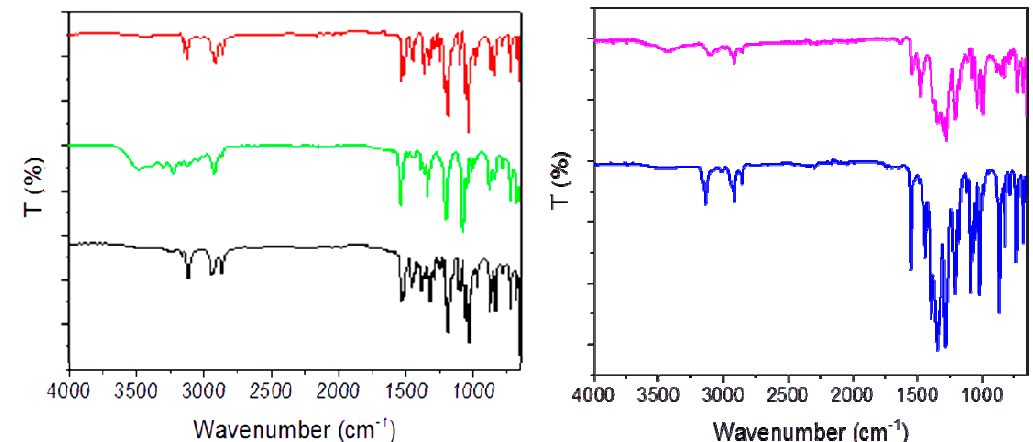
Figure 1. IR spectra of [Zn(tr 2 ad)Cl 2 ] n (black), {[Cu(tr 2 ad)Cl]Cl ∙ 4H 2 O} n (green), [Cd 2 (tr 2 ad)Cl 4 ] n (red), {[Cu(tr 2 ad)(NO 3 )](NO 3 )} n (blue) and {[Cd(tr 2 ad)(NO 3 )](NO 3 ) ∙ H 2 O} n (fuchsia).